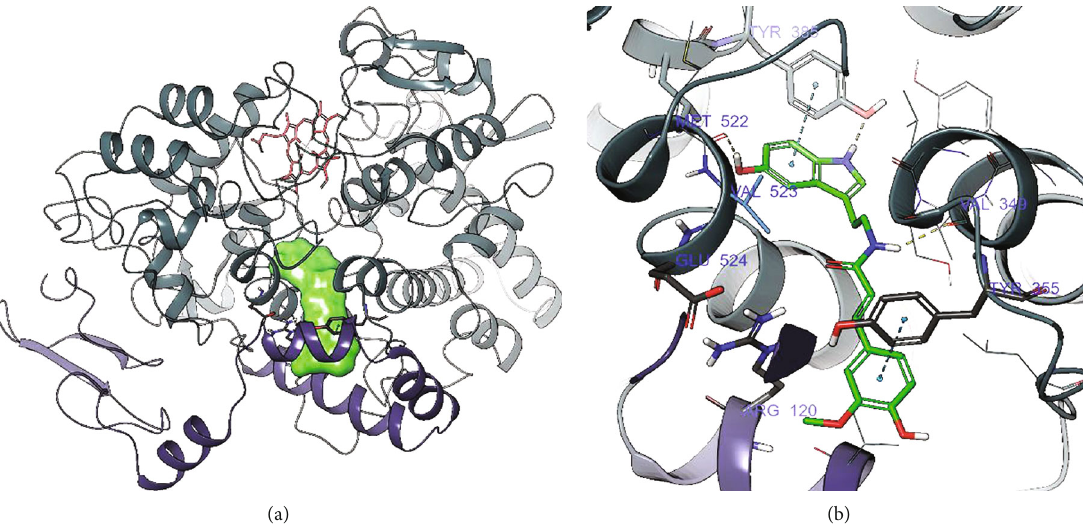
Figure 8: (a) Human COX-2 (PDB 5KIR) with docked N -feruloylserotonin in the active site shown as green surface. The heme group is depicted as red stick model. The three-pocket entry-restricting residues Arg120, Glu524, and Tyr355 surround the docked ligand as stick models. (b) Binding hypothesis of N -feruloylserotonin to COX-2 (docking score -11.41 kcal/mol). Protein-ligand interactions are indicated as blue dashed lines for aromatic interactions and yellow dashed lines for hydrogen bonds. Tyr385 has been shown to be actively involved in electron transfer between natural substrate arachidonic acid and heme [60].